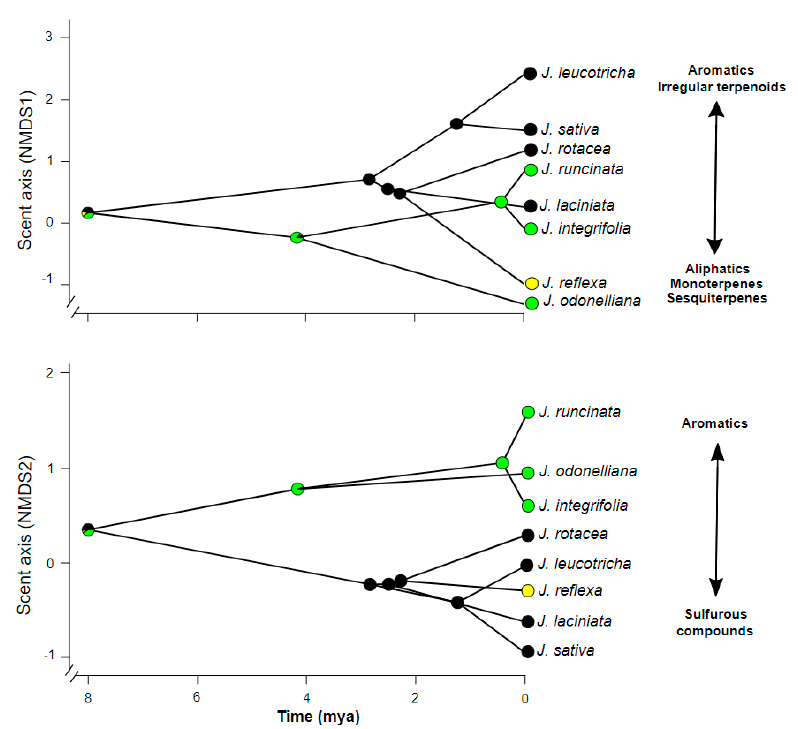
Figure 4. Reconstruction of floral scent and pollination mode in Jaborosa Juss. Phylogenetic relation- ships among the eight Jaborosa species were projected in the space defined by floral scent profile; y-axis: NMDS1 (above) and NMDS2 (below) scores from Figure 3; x-axis: divergence time. Pie charts on each node show the posterior probability of each pollination mode (nocturnal hawkmoths in green, generalist by small insects in yellow and saprophilous flies in black) retrieved by 100 stochastic character mappings (see text for further details). Chemical classes of the floral VOCs that are important explaining the ordination are shown on the right.